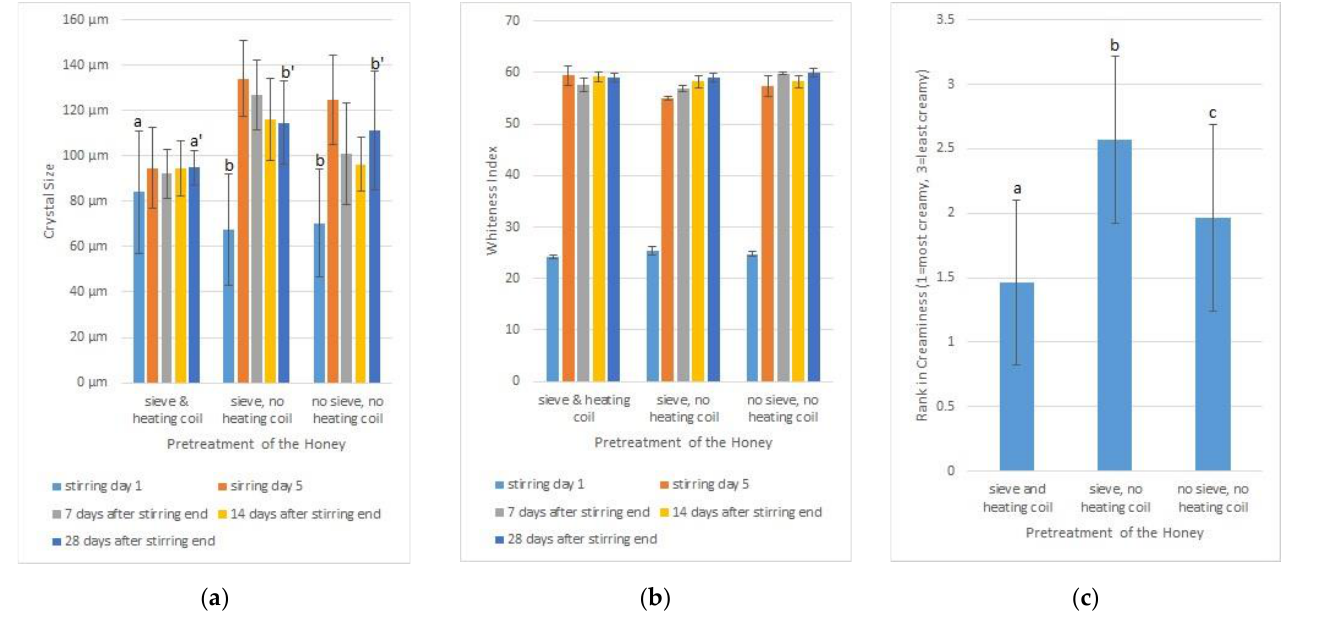
Figure 2. Influence of the honey pretreatment on its creaminess. (a, b, c, a’, b’ denote groups of significantly different samples.) ( a ) Mean and standard deviation of the size of the 10 largest crystals on different days. ( b ) Mean and standard deviation of whiteness index of the honey on different days. ( c ) Mouthfeel of the honey, tested by 41 trained sensory testers by ranking test (average rank and standard deviation).